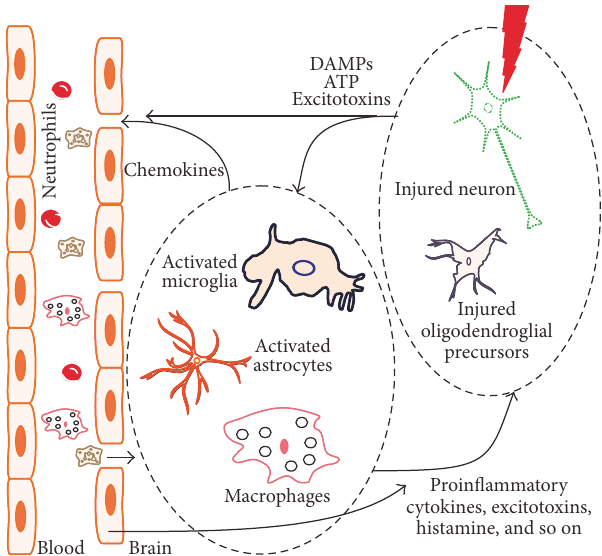
Figure 1: Scheme of early innate response to brain injury. Damage signals or DAMPs primarily released from the injured parenchymal cells are sensed by immune effector cells such as microglia, astro- cytes, and macrophages. The triggered innate immune response (e.g., proinflammatory cytokines, chemokines, reactive oxygen species, excitotoxins, histamine, and prostaglandins) has detrimen- tal influences on the neurons, oligodendroglial precursors, and vas- cular endothelial cells. The increased BBB permeability contributes the migration of peripheral immune cells (e.g., neutrophils, mast cells, and macrophages) to the sites of tissue